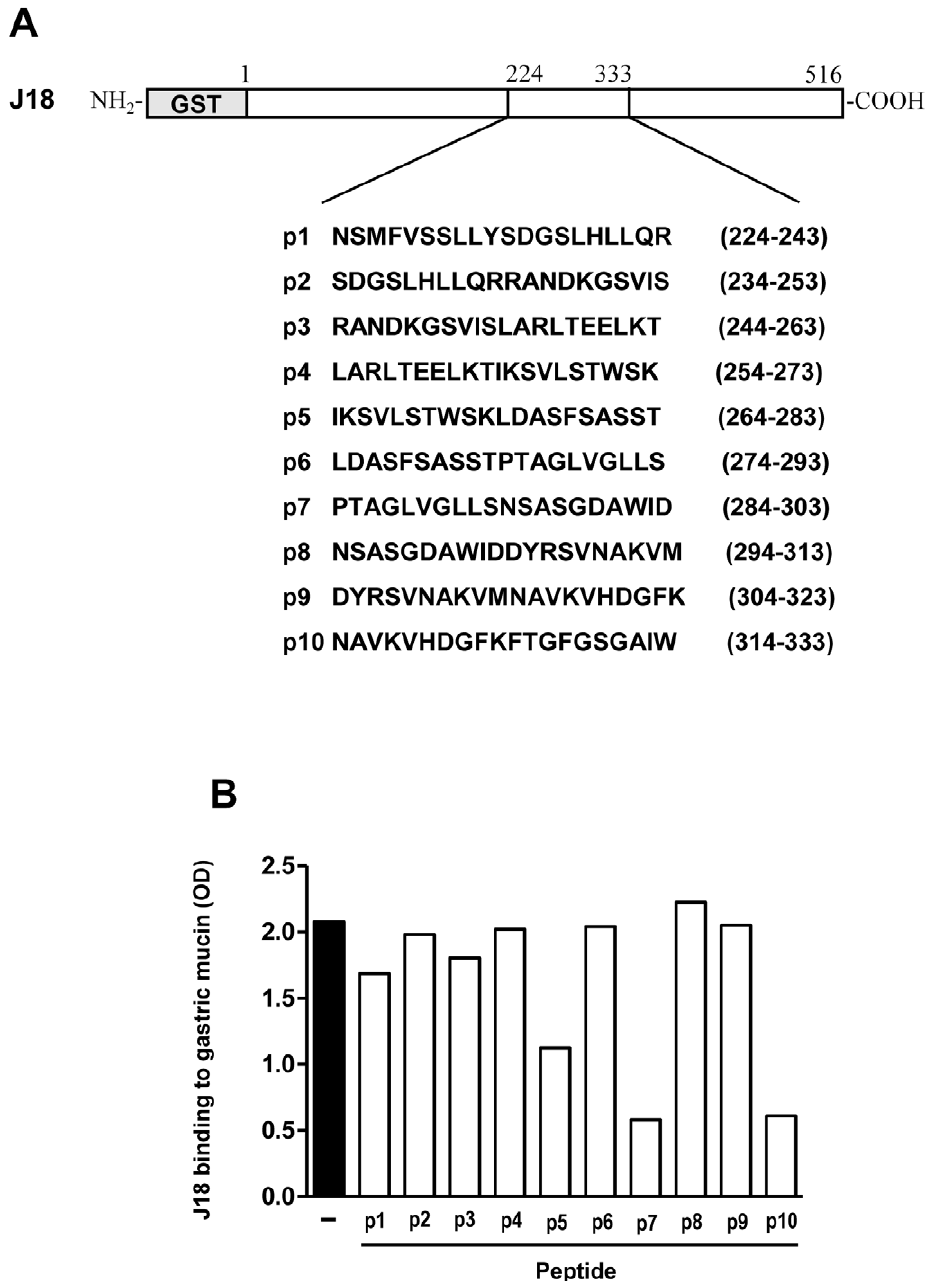
Figure 3. Determination of T.cruzi gp82 sequences implicated in binding to gastric mucin. A) Amino acid composition of peptides corresponding to gp82 central domain. Shown are the 20-mer peptides with an overlap of 10 residues. B) Effect of peptides shown in (A) on J18 binding to gastric mucin. Values are the means of triplicates of representative assays (variation between triplicates , 10%).